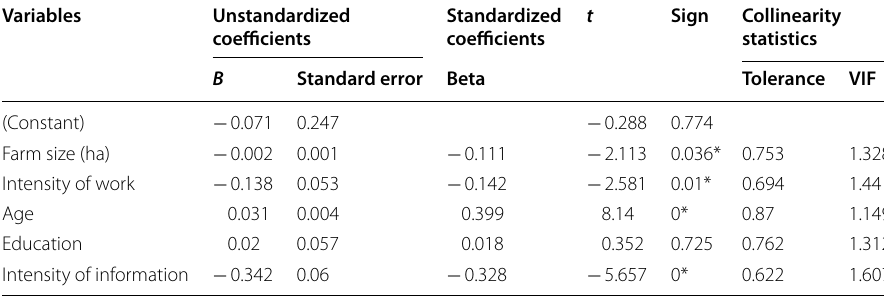
* significant at the 0.05 level (2-tailed)